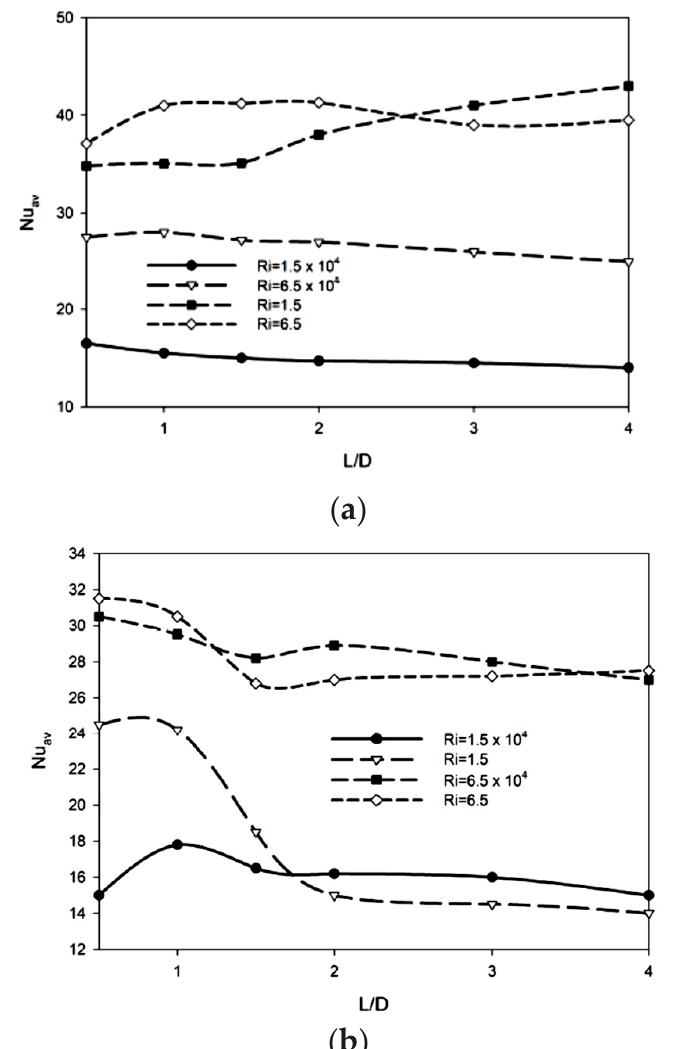
Figure 10. Average Nusselt number in function of the aspect ratio L / D in assisting ( a ) and opposing ( b ) configuration.